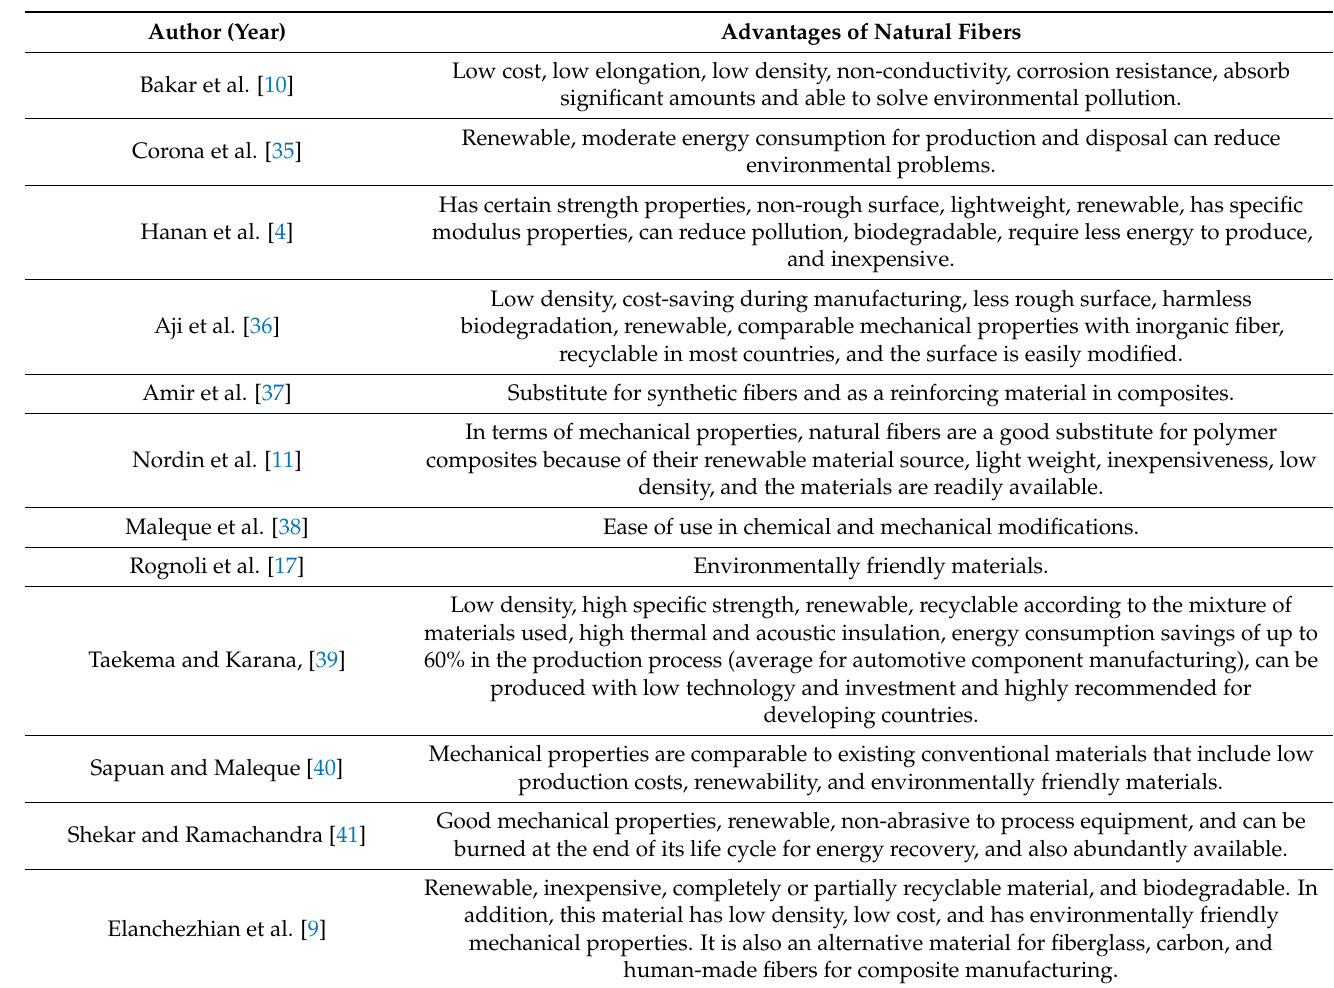
Table 2. The advantages of natural